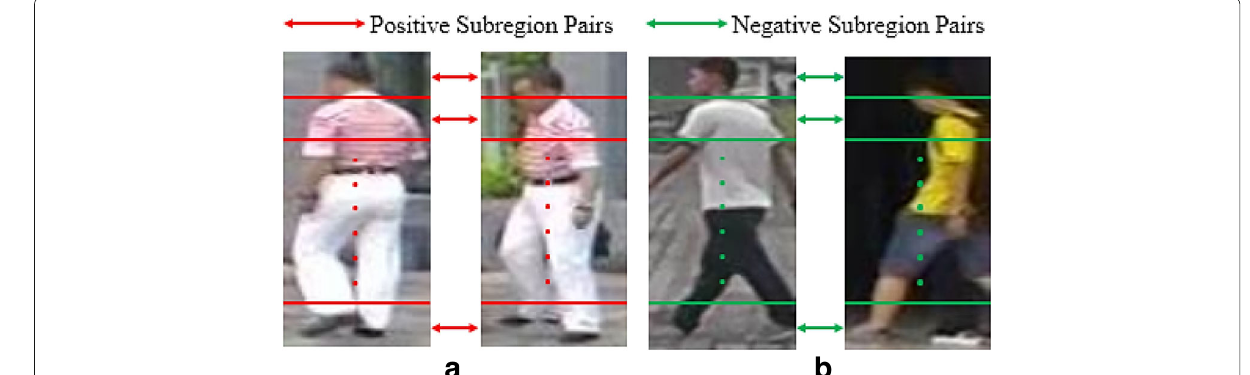
Fig. 3 Illustration of the a positive and b negative subregion